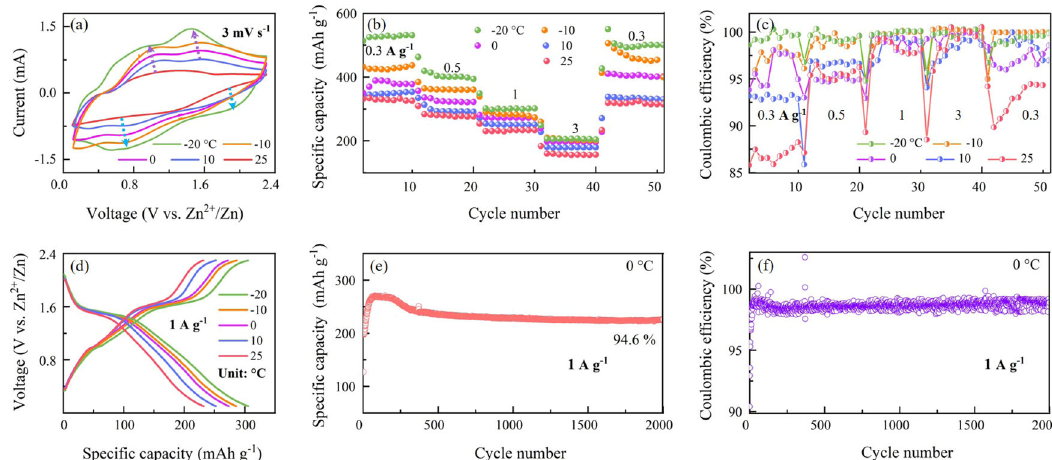
Fig. 3 Electrochemical performance of the rechargeable quasi-solid Zn||E-Bi 2 Se 3 cells over the temperature range − 20 to 25 °C. a CVs of quasi-solid Zn||E-Bi 2 Se 3 cells at different temperatures. b Rate capability and corresponding CE ( c ) and GCD pro fi les ( d ) of the quasi-solid AZIB at different temperatures. e Long-cycle discharge capacity and corresponding CE ( f ) at 0 °C.